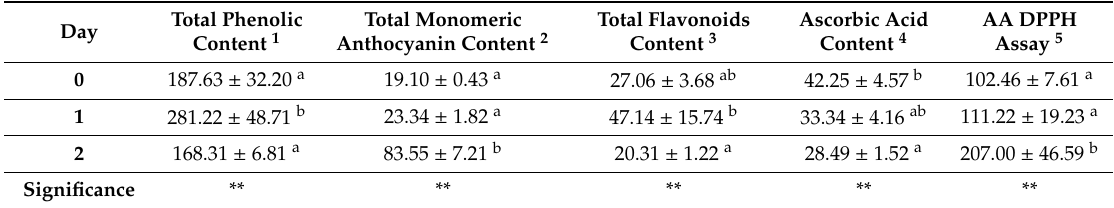
Table 1. Fruits left at room temperature without film. E ff ect of storage period, from harvest on the total phenolic content, total monomeric anthocyanin content, total flavonoid content, the ascorbic acid content, and the antioxidant activity DPPH parameters in red raspberries (cv. Erika). The results are the mean of three replicates ± Standard Deviation. The letters represent the significant di ff erence vertically; ** ( P ≤ 0.01). The letters represent the significant di ff erence vertically at P ≤ 0.05.